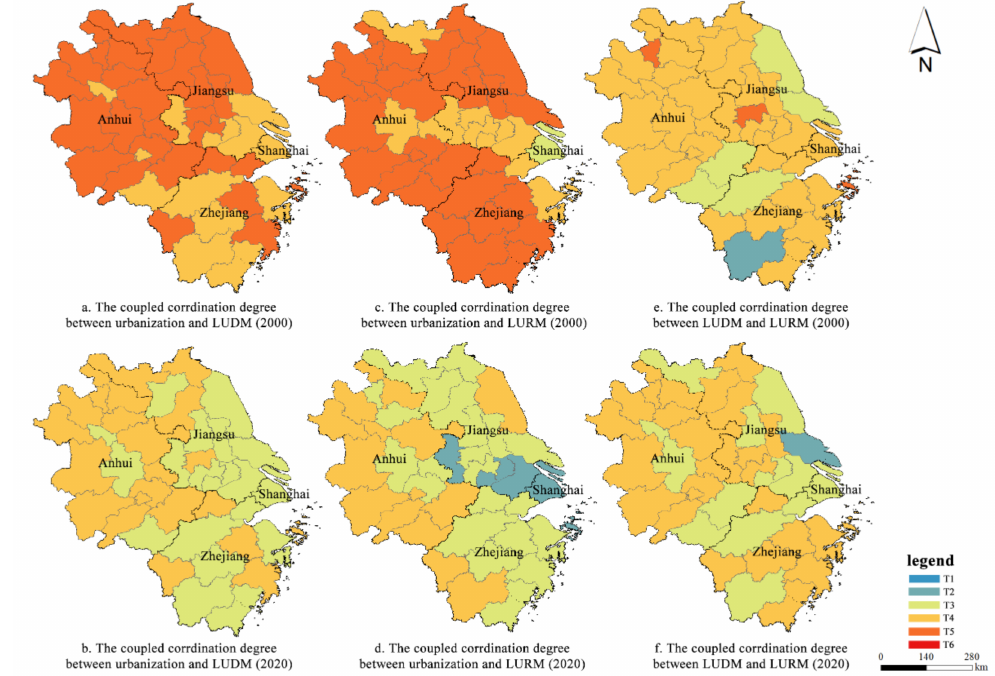
Figure 6. Spatial evolution of the coupling coordination relationship between urbanization and land-use morphology in the Yangtze River